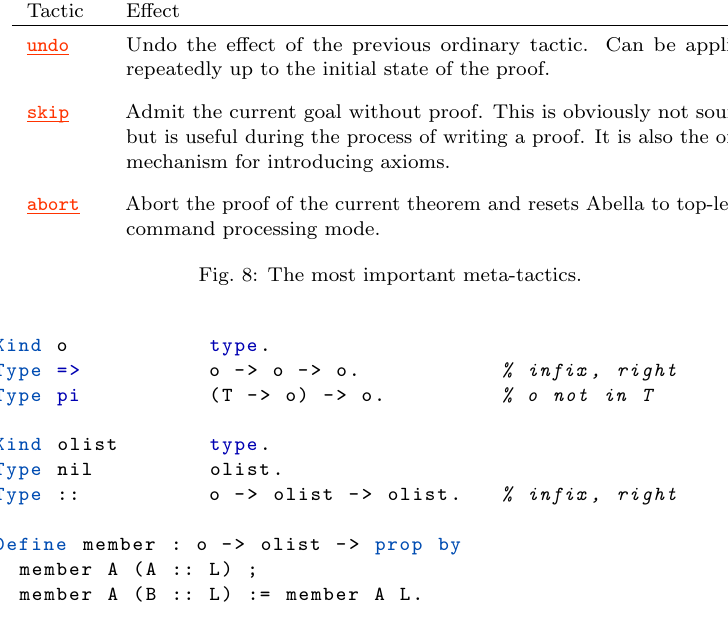
Fig. 9: The declarations and definitions that are implicitly included in every Abella development. Everything in this color is treated as a keyword as it violates the lexical or typing conventions of ordinary declarations and